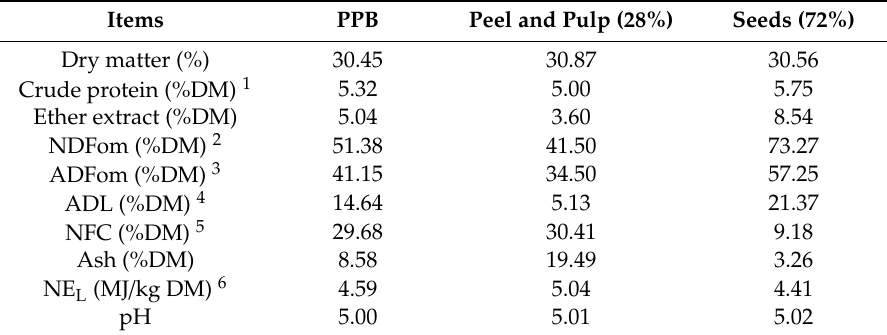
Table 1. Chemical composition of prickly pear by-product (PPB) and its